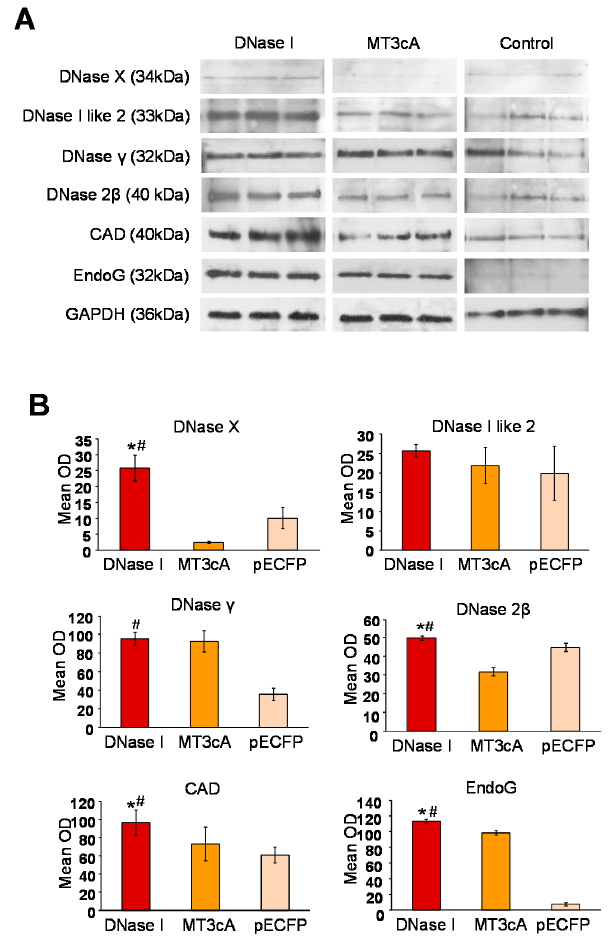
Figure 3. Inactive DNase I mutant does not induce other endonucleases. ( A ) Western blotting for DNase X, DNase I like 2, DNase γ , DNase 2 β , CAD, EndoG, and GAPDH (as a loading control) in